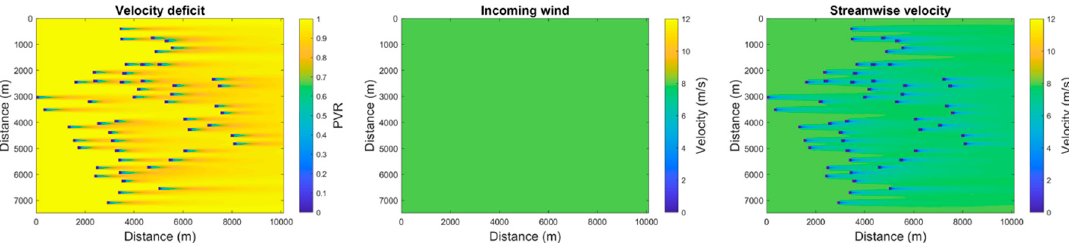
Figure 6. Generation of streamwise velocity map based on velocity deficit map multiplied from the average incoming velocity.